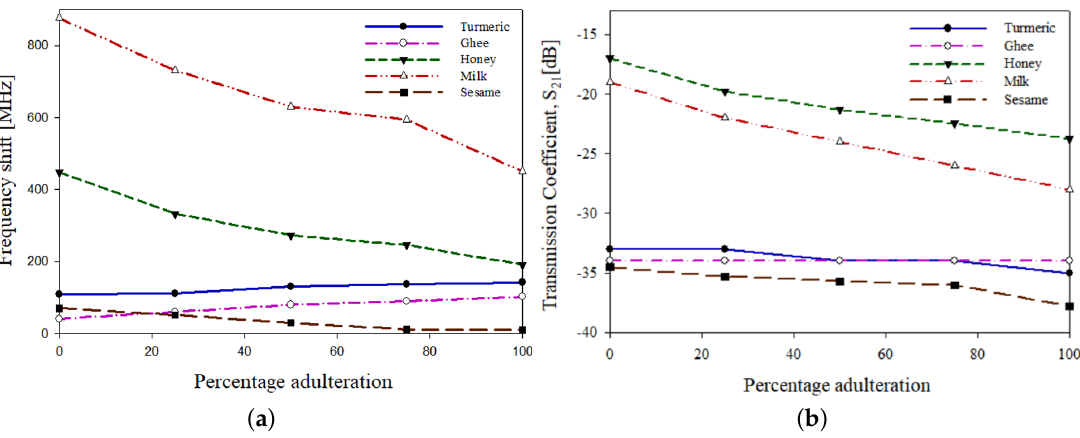
Figure 32. Adulteration testing in sesame oil: ( a ) variation in scattering parameters with frequency ( b ) and variation in the transmission coefficient parameters with